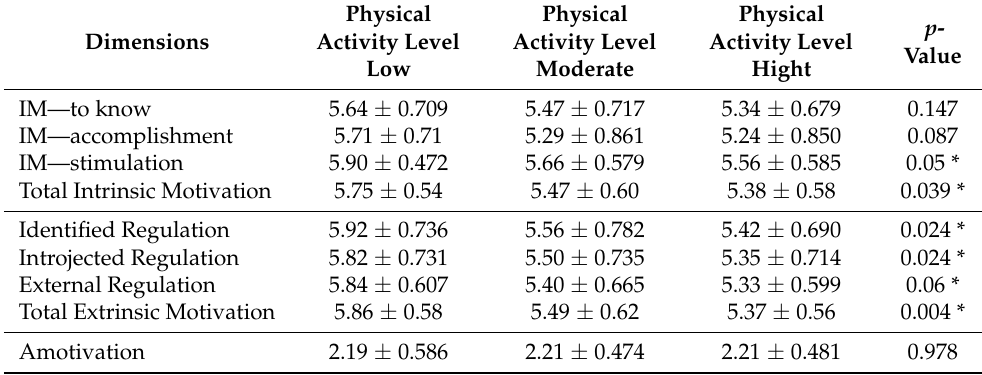
Table 3. Dimensions of Motivation according to Physical Activity